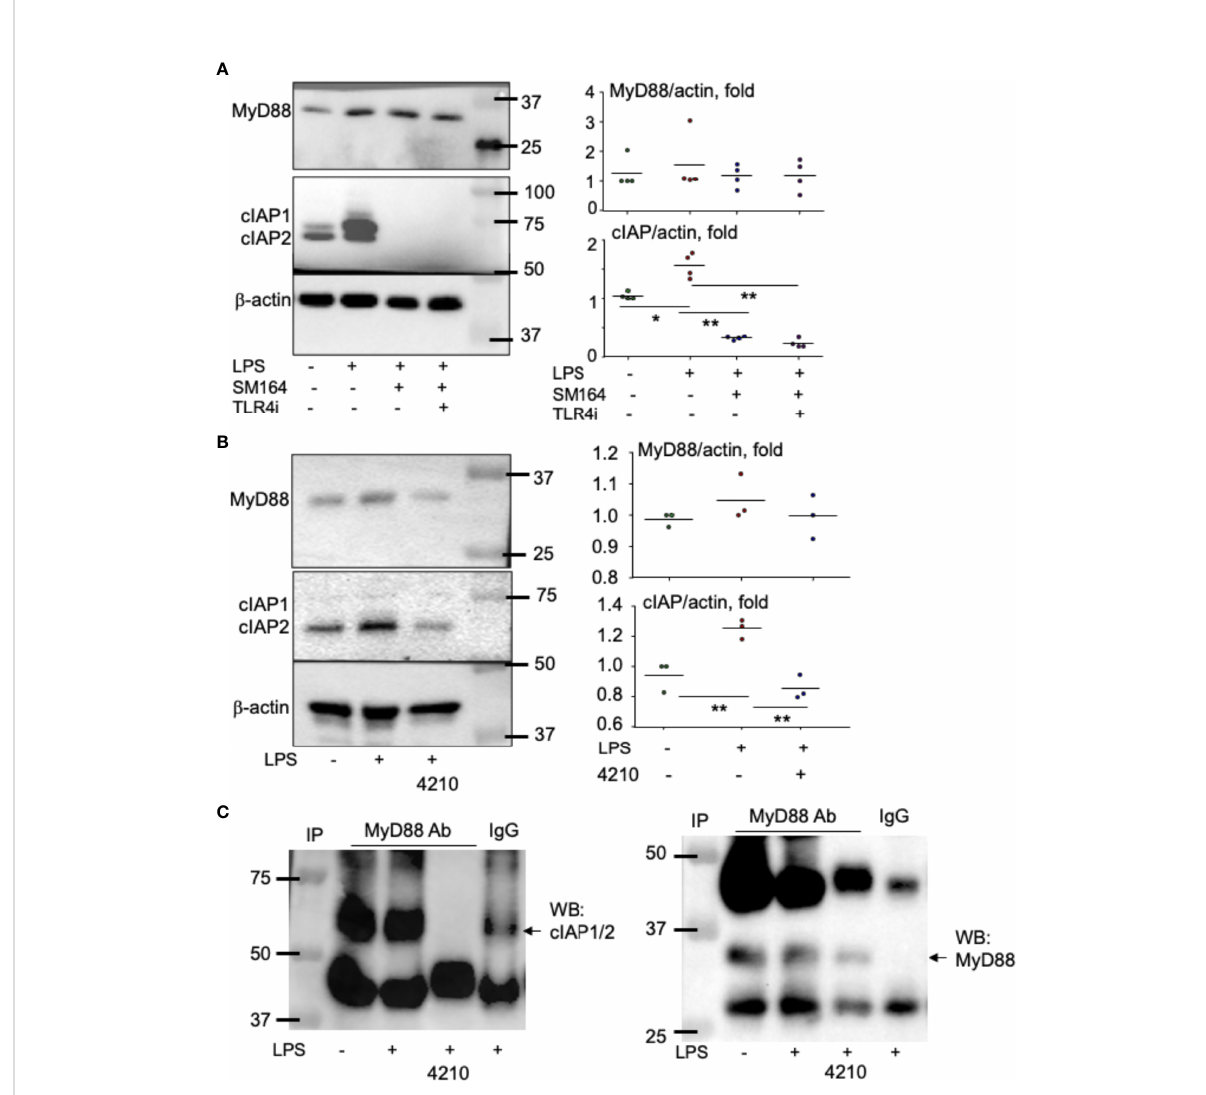
FIGURE 5 MyD88 associates with and stabilizes cIAP proteins. MDA-MB-231 cells at sub-con fl uence were treated with LPS (100 ng/ml) or its combination with SM-164 (3 nM) − /+ TLR4i (5 m M) (A) and were treated with LPS (100 ng/ml) − /+ MyD88 inhibitor 4210 (10 m M) (B) for 8 h; 20 m g of whole- cell lysate protein from each sample was used to test protein levels of MyD88, cIAP1/2, and b -actin by Western blotting (WB). The quanti fi ed WB data were from fi ve (A) or three (B) repeats. *p < 0.05 and **p < 0.01 between the indicated groups. (C) Cell lysate protein measuring 300 m g from samples, as in panel B, was immunoprecipitated with anti-MyD88 antibody − /+ 10 m M of MyD88 inhibitor 4210. In addition, one sample was incubated with normal IgG. The pulldown proteins were used to test cIAP1/2 and MyD88 by WB. The experiments were repeated three times with similar